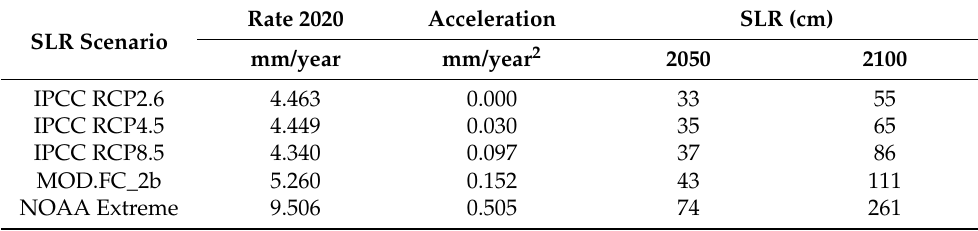
Table A2. SLR rates for 2020, acceleration and SLR values for 2050 and 2100 for the considered